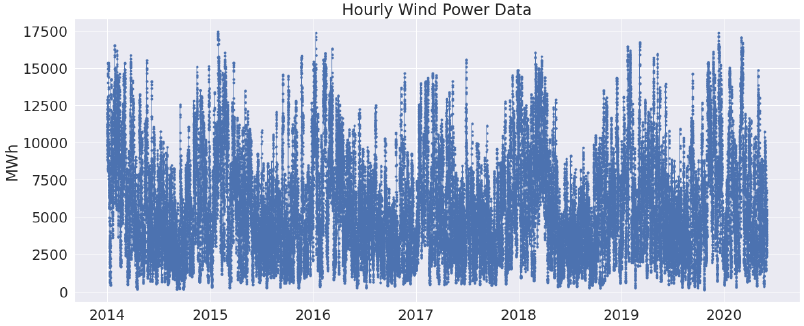
Figure 1. Real wind power time series data from January 2014 to May